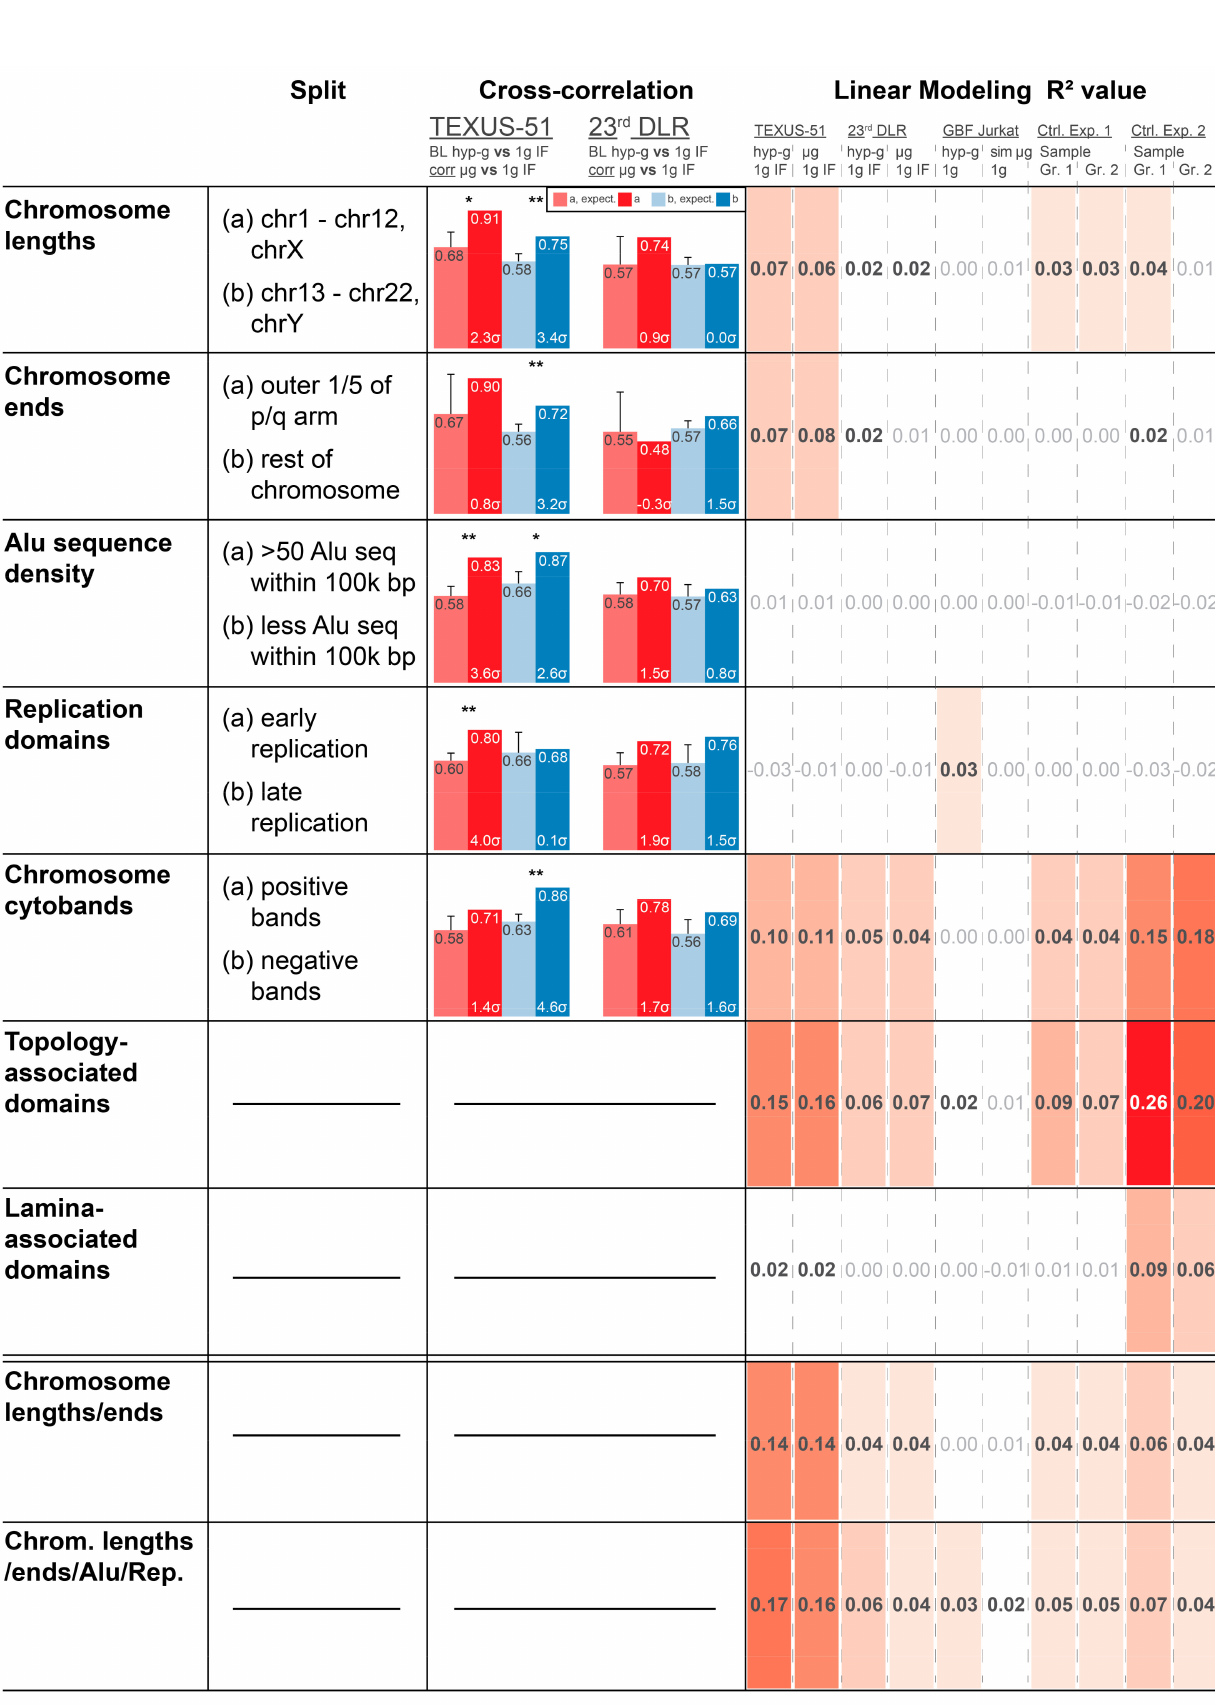
Figure 4. Model hypothesis testing results on the analysis of different potential underlying DNA structures that could be involved in the observed differential gene expression patterns. Each row represents one structural element, and the last